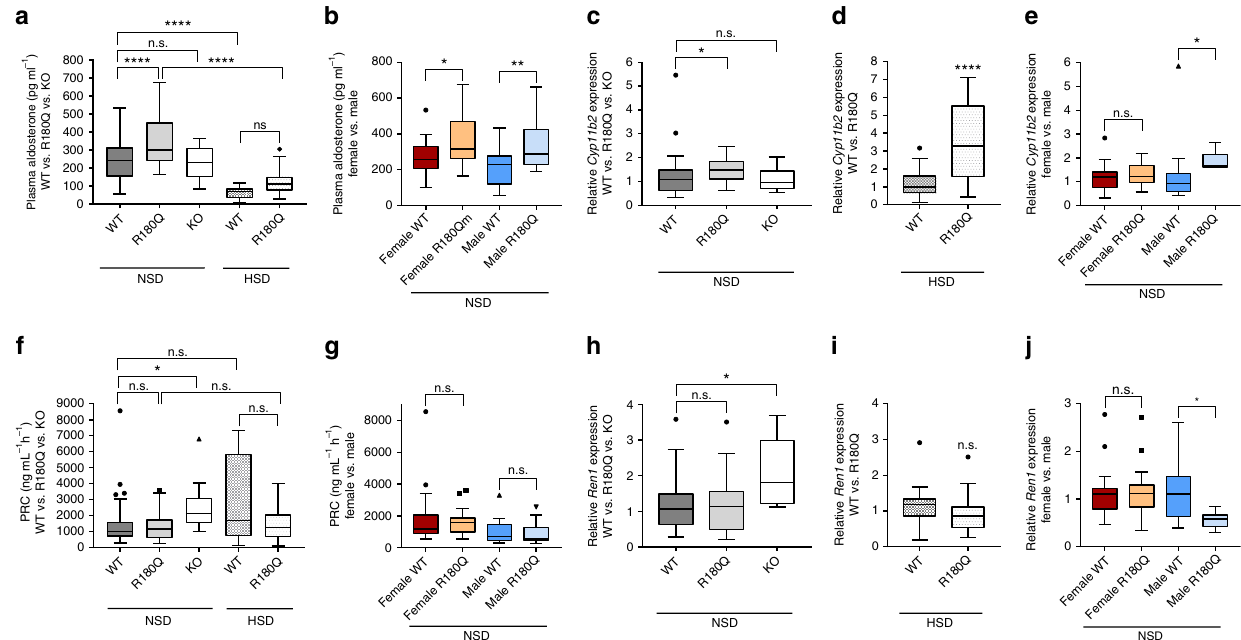
Fig. 4 Clcn2 R180Q/ + mice have elevated Cyp11b2 expression and plasma aldosterone levels. a, c, d Plasma aldosterone (WT: N = 37; Clcn2 R180Q/ + : N = 36; P < 0.0001; one-way ANOVA, Sidak´s MCP; F = 4.161; df = 120) and Cyp11b2 expression (WT: N = 32, 1.23 ± 0.17; Clcn2 R180Q/ + : N = 25, 1.47 ± 0.1; P = 0.0431; one-way ANOVA, Sidak´s MCP of log-transformed fold change; F = 2.907; df = 63) are signi fi cantly increased in Clcn2 R180Q/ + mice. Clcn2 − / − mice have unchanged plasma aldosterone ( N = 10; P = 0.999; F = 4.313; df = 118) and Cyp11b2 expression ( N = 10; P = 0.9959; both one-way ANOVA including Sidak´s MCP; F = 2.907; df = 63). HSD leads to suppressed aldosterone levels in WT (WT: N = 37; HSD-WT: N = 19; P < 0.0001) and Clcn2 R180Q/ + ( Clcn2 R180Q/ + : N = 36; HSD- Clcn2 R180Q/ + : N = 23; P < 0.0001; both one-way ANOVA, Sidak´s MCP; F = 4.313; df = 118). Cyp11b2 expression is upregulated in Clcn2 R180Q/ + compared to WT (HSD-WT: N = 24; HSD- Clcn2 R180Q/ + : N = 27; P < 0.0001; Mann – Whitney test). b, e Plasma aldosterone is elevated in females (WT: N = 21; Clcn2 R180Q/ + : N = 23; P = 0.0323; df = 69) and males (WT: N = 16; Clcn2 R180Q/ + : N = 13; P = 0.0098; both one-way ANOVA, Bonferroni´s MCP; F = 5.589; df = 69), Cyp11b2 expression is upregulated only in male Clcn2 R180Q/ + (WT: N = 15; Clcn2 R180Q/ + : N = 7; P = 0.0275; one-way ANOVA including Sidak´s MCP; F = 1.782; df = 53). f, h, i PRC is unchanged (WT: N = 37, 1474 ± 245.3 ng ml − 1 h − 1 , Clcn2 R180Q/ + : N = 36, 1334 ± 138.7 ng ml − 1 h − 1 , P > 0.9999; HSD-WT: N = 19, 2830 ± 590.3 ng ml − 1 h − 1 ; HSD- Clcn2 R180Q/ + : N = 23, 1522± 218.4 ng ml − 1 h − 1 , P > 0.9999; both Kruskal – Wallis test, Dunn´s MCP). Ren1 expression is unchanged (WT: N = 32, 1.17 ± 0.12; Clcn2 R180Q/ + : N = 27, 1.16 ± 0.14; P = 0.9812; one-way ANOVA including Sidak´s MCP; F = 0.7894; df = 63; HSD-WT: N = 24, 1.26 ± 0.15; HSD- Clcn2 R180Q/ + : N = 27, 1.462 ± 0.23; P = 0.9813; Mann – Whitney 0.7894; df = 63) and PRC (WT: N = 37, 1474 ± 245.3 ng ml − 1 h − 1 ; Clcn2 − / − : N = 10, 2602 ± 546.1 ng ml − 1 h − 1 ; P = 0.03; Kruskal – Wallis test, Dunn´s 0.9999;) as well as male mice (WT: N = 16, 995.1 ± 194.7 ng ml − 1 h − 1 ; Clcn2 R180Q/ + : N = 13, 882.6 ± 198 ng ml − 1 h − 1 ; P > 0.9999; both Kruskal-Wallis ± 0.16; Clcn2 R180Q/ + : N = 7, 0.57 ± 0.07; P = 0.0158; one-way ANOVA including Sidak´s MCP; F = 0.6378; df = 53). Mean ± SEM for all data in the legend; box plots (box, interquartile range; whiskers, 1.5 times the interquartile range; line, median; dots, outliers) are shown in the fi gure; N values are biologically independent animals. NSD, normal salt diet. *, p < 0.05; **, p < 0.01; ****, p < 0.0001; n.s., p > expression and renal Ren1 expression. This revealed incomplete (systolic, 120.6 ± 0.1 mmHg versus 116.4 ± 0.1 mmHg; P = 0.007; suppression of relative Cyp11b2 expression in Clcn2 R180Q/ + mice diastolic, 88.0 ± 0.1 mmHg versus 84.2 ± 0.1 mmHg; P = 0.020; MAP, 103.8 ± 0.1 versus 100.1 ± 0.1; P = 0.009; all mean ± SEM (2.85 ± 0.34) compared to WT mice (1.34 ± 0.23, mean ± SEM, and Nested-model likelihood ratio comparisons). Heart rate was P < 0.0001; Mann – Whitney test) (Fig. 4d). not signi fi cantly changed in Clcn2 R180Q/ + (507.9 ± 0.4 BPM, mean ± SEM) versus WT (495.2 ± 0.4 BPM; P = 0.225; Nested- Aged Clcn2 R180Q/ + mice show no evidence of end-organ model likelihood ratio comparisons) (Fig. 7). Clcn2 R180Q/ + mice show an altered high-salt response . Hyper-